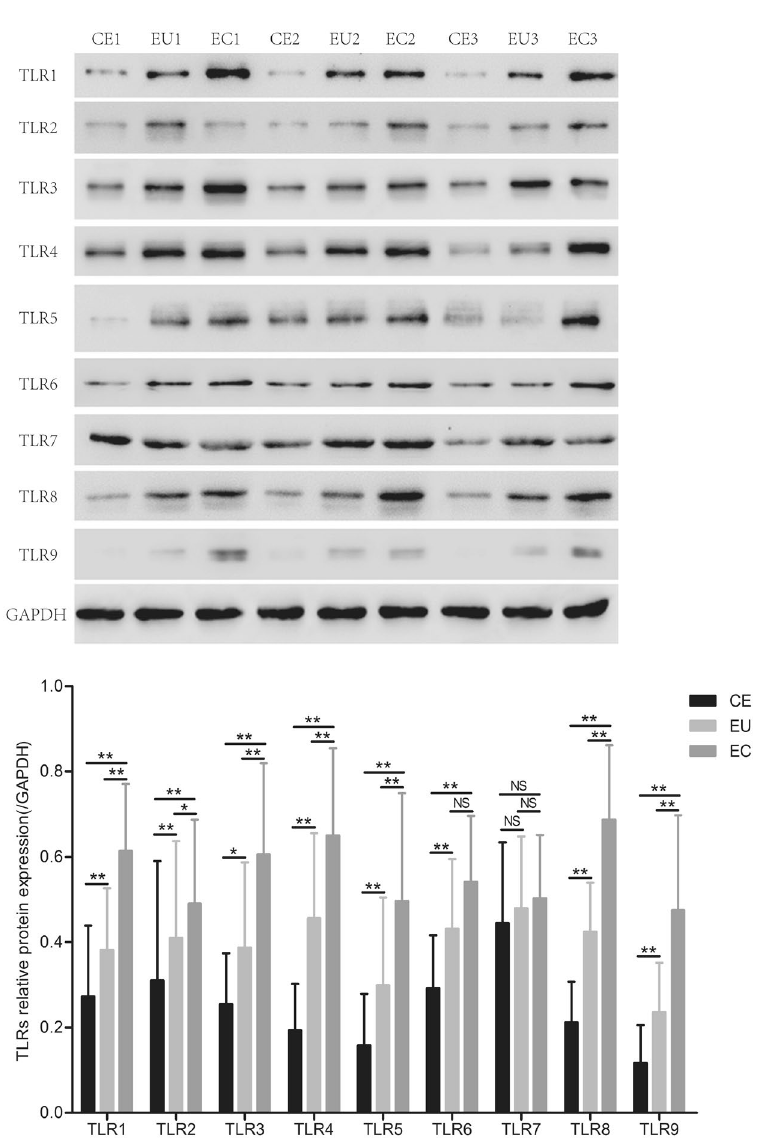
Figure 2. Protein expression of TLRs in CE, EU and EC. CE: endometrium without adenomyosis; EU: eutopic endometrium with adenomyosis; EC: ectopic endometrium with adenomyosis. NS P > 0.05; * P < 0.05; ** P <